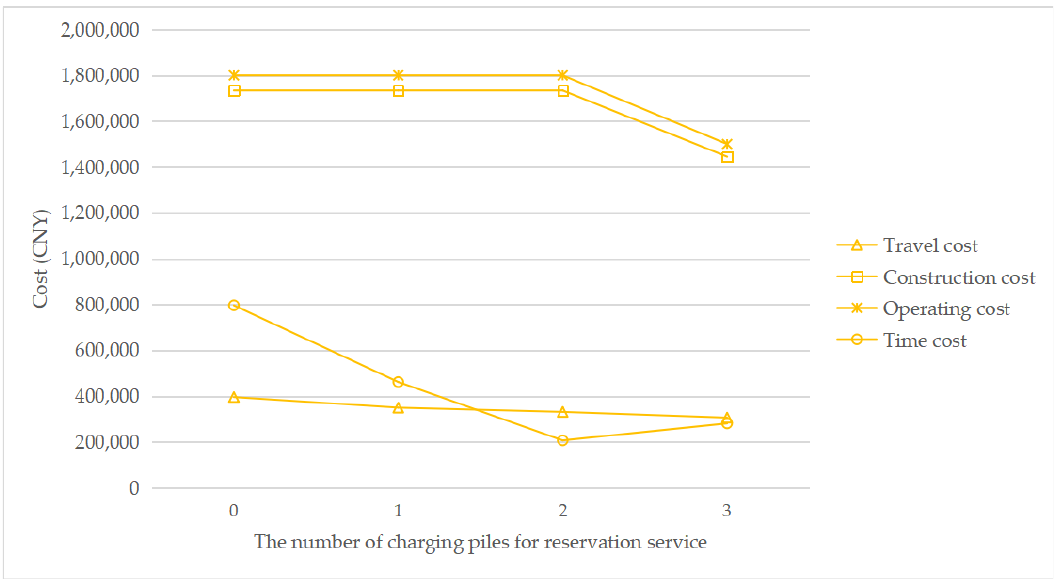
Figure 9. Cost change with a changing number of charging piles for the reservation service under τ = 0.15.